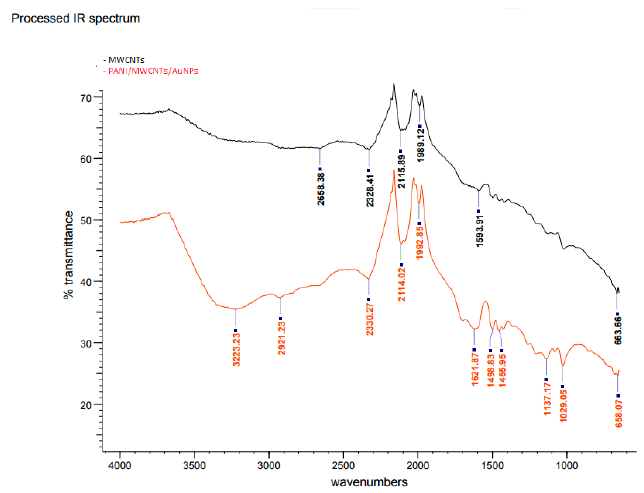
Figure 3. FTIR spectra of bare and modified ITO electrodes.